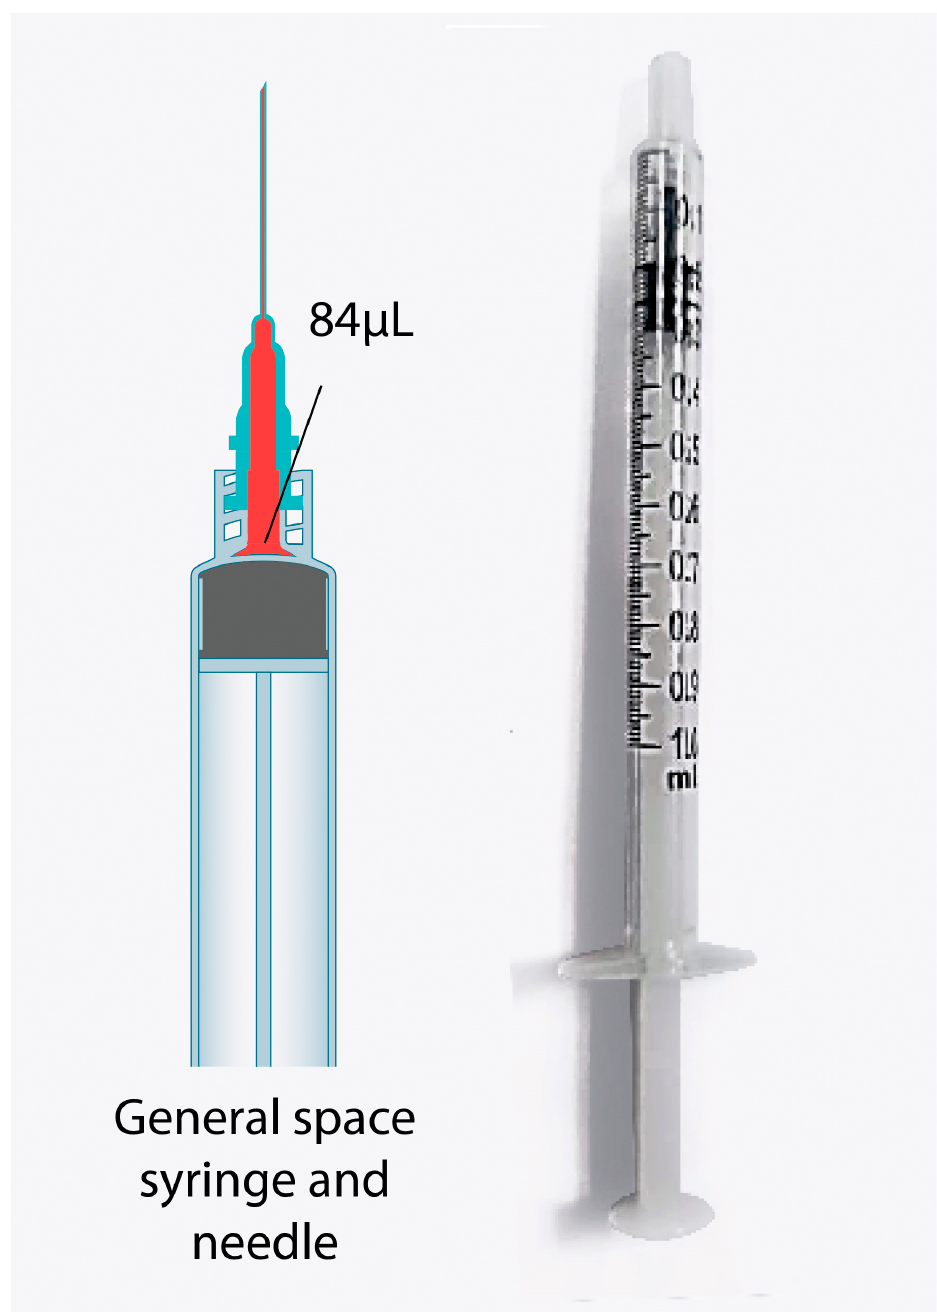
Figure 1. General space syringe and needle.